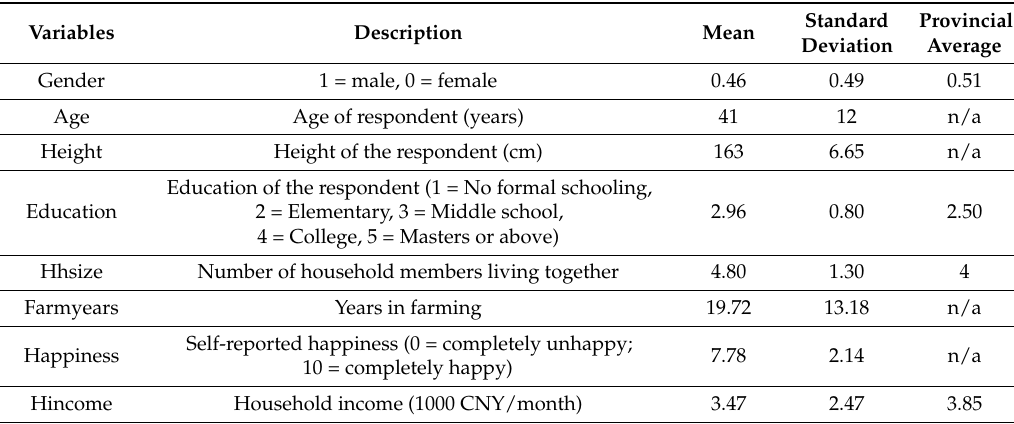
Table 2. Main socioeconomic variables and their mean